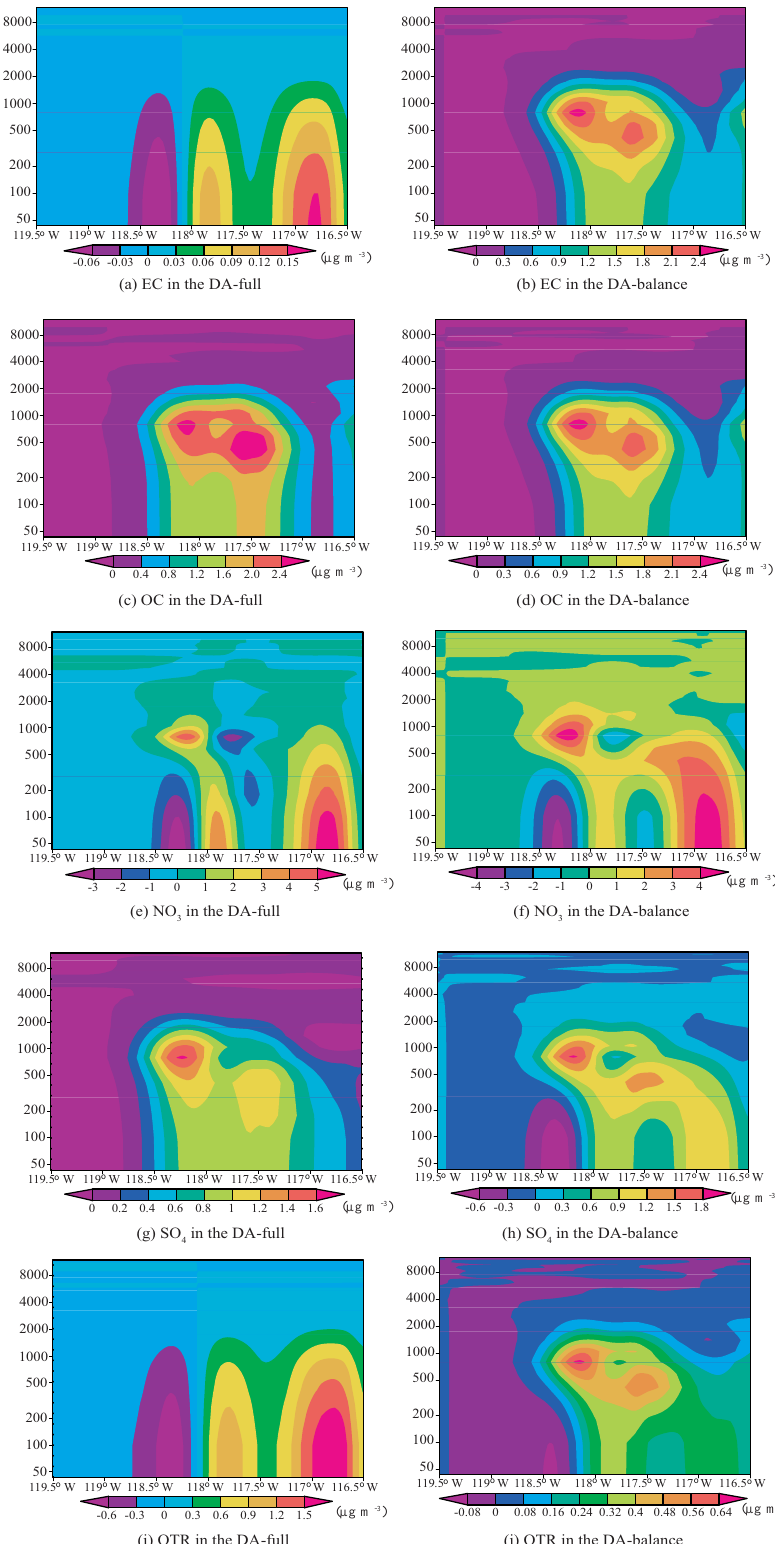
Figure 10. Same as Fig. 9, with the exception of the vertical sections along 35 ◦